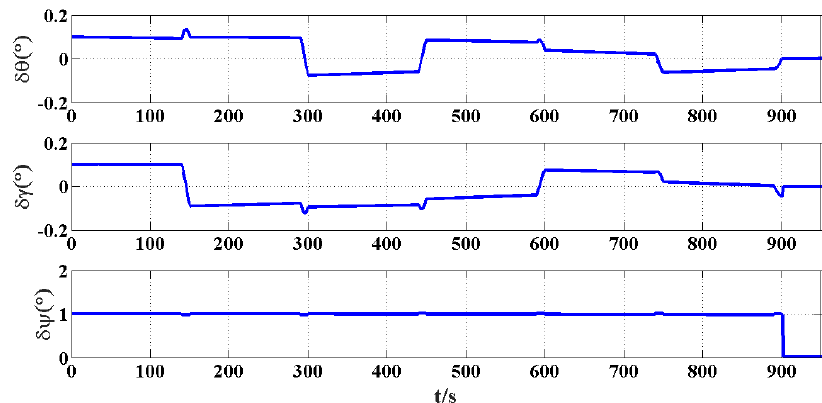
Figure 13. Attitude error of in-motion alignment of s-shaped maneuver.